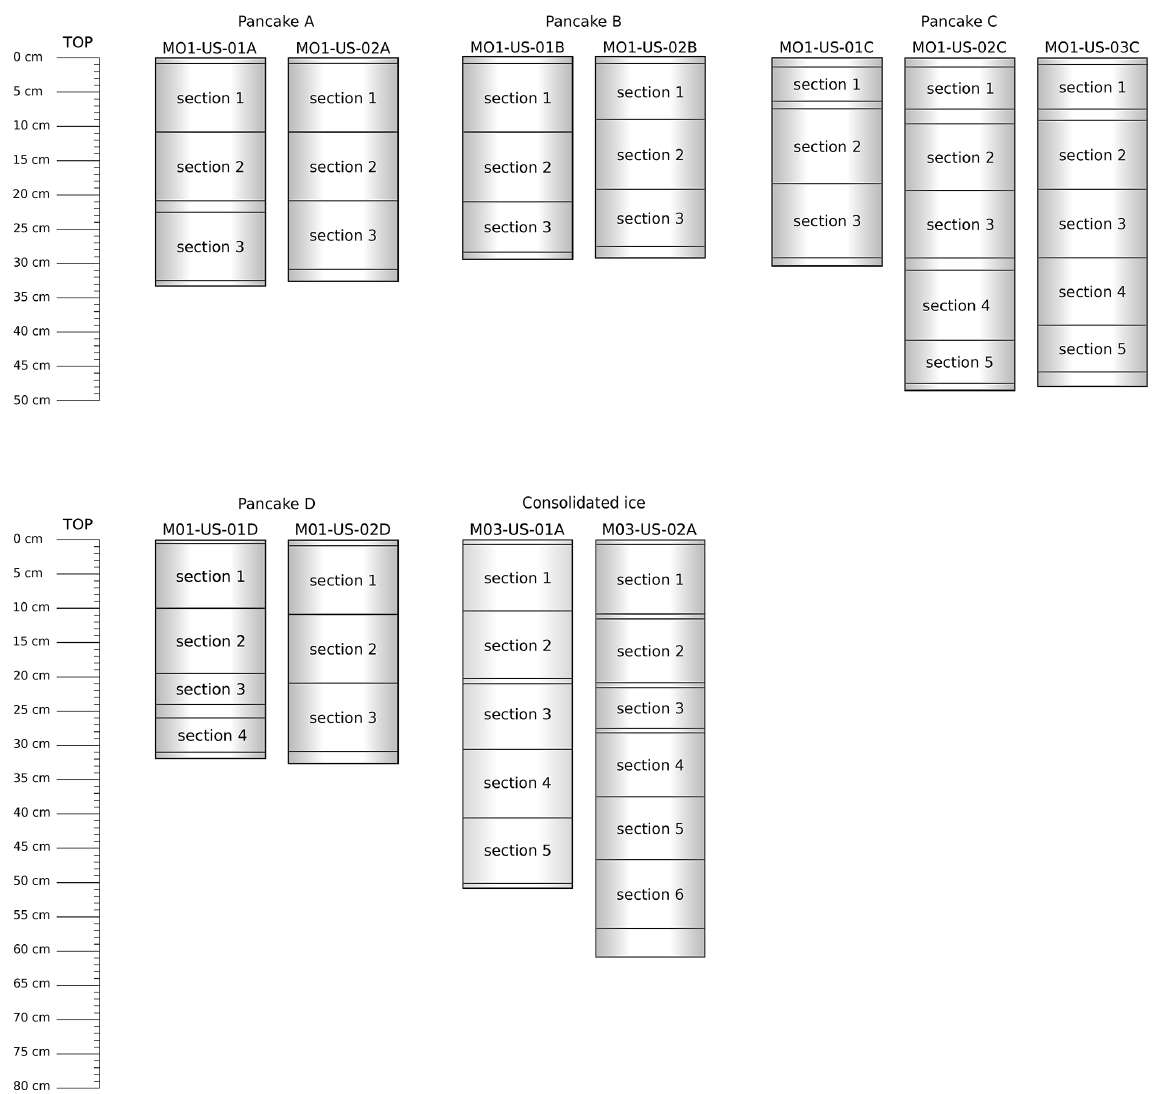
Figure B1. Schematic of the segmentation of seven pancake ice and two pack ice cores subjected to ultrasound testing with section dimen- sions and corresponding section